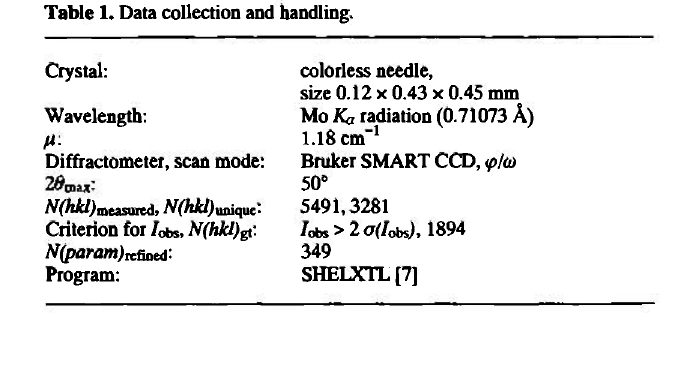
Table 1. Data collection and